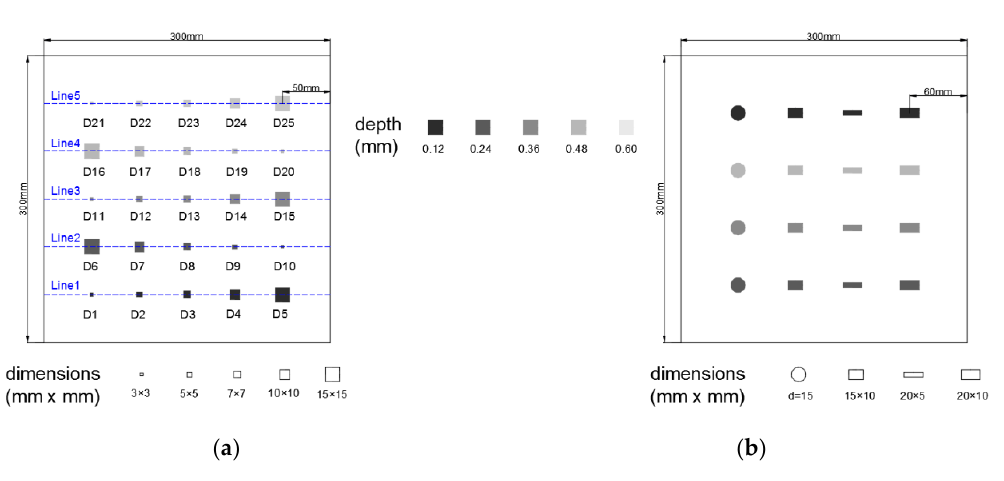
Figure 4. Sketch of the specimen A ( a ) and the specimen B ( b ). The dash lines used in the discussion section are also demonstrated in ( a ).